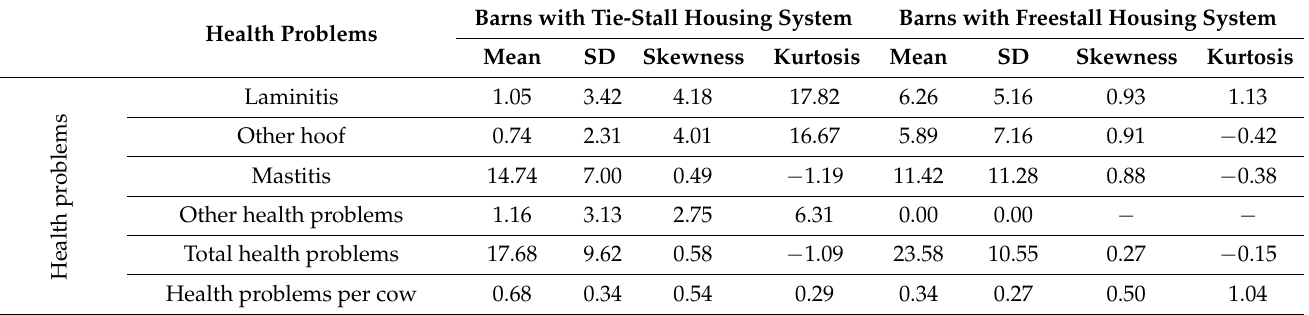
Table 5. Descriptive statistics on health problems in the investigated dairy farms, including the number of health problems per barn during the last 12